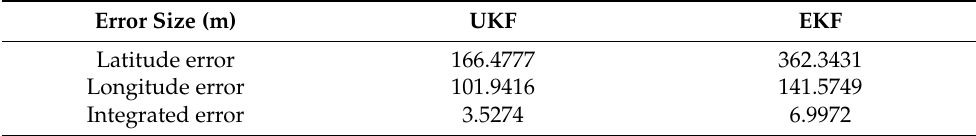
Figure 8. Analysis of UKF and EKF track prediction results: ( a ) UKF and EKF trajectory forecast; ( b ) UKF and EKF latitude and longitude coordinates prediction error size; ( c ) combined UKF and EKF prediction errors. Table 1. UKF and EKF error